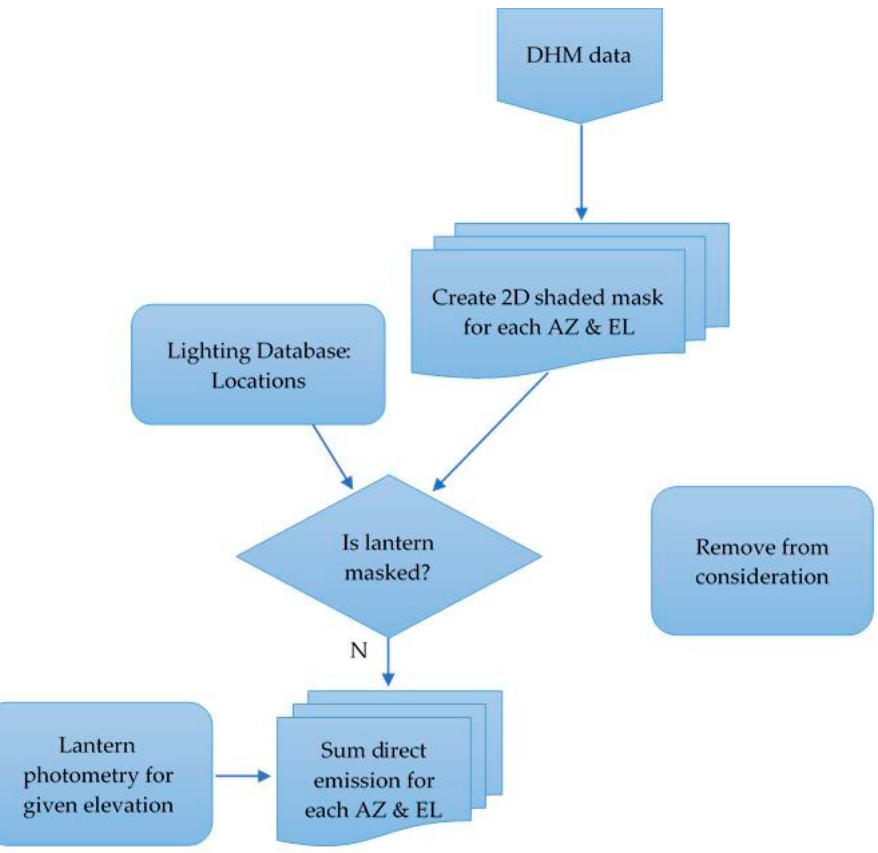
Figure A2. Flowchart of decision to include lantern in direct zenithal emission.